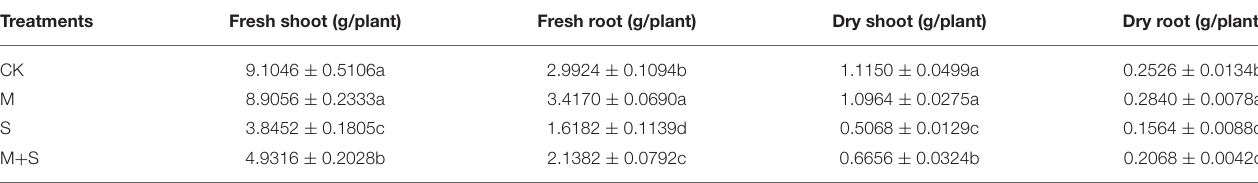
TABLE 2 | Effects of exogenous melatonin on fresh and dry weights in tomato seedlings. Treatments Fresh shoot (g/plant) Fresh root